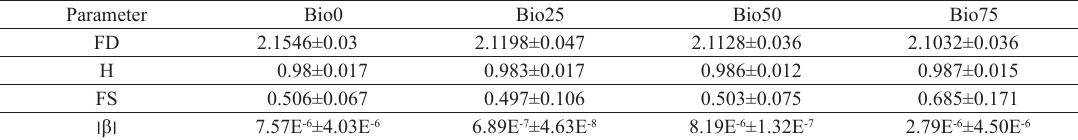
Table 4. Results of Fractal Dimension FD, Topographic Entropy (H), Fractal Succolarity (FS), and Lacunarity Coefficient (β). The average results were expressed as mean value and standard deviation.